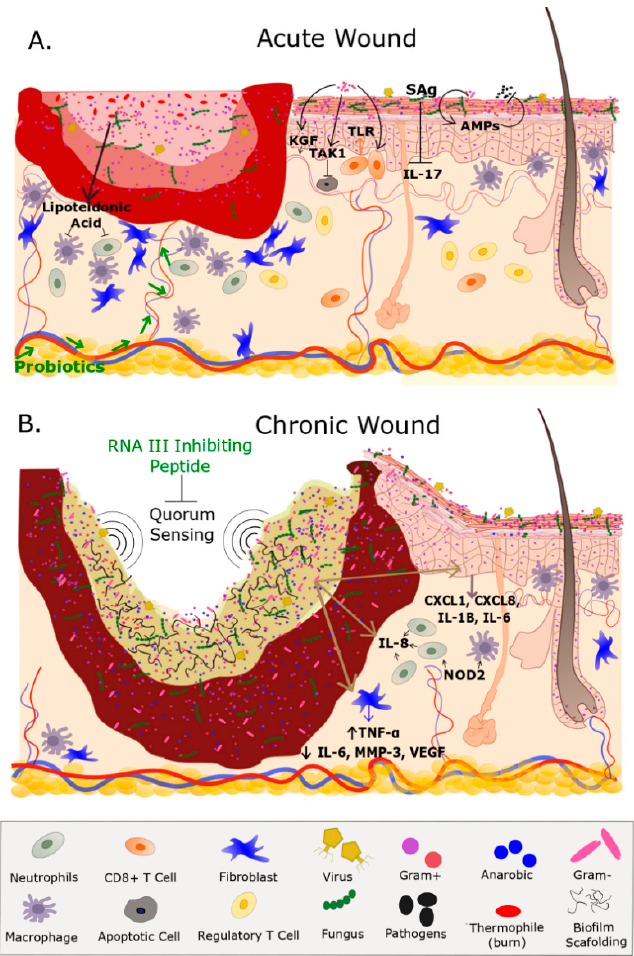
Figure 1. Microbiome, Wound Healing, and Wound Healing Impairment. ( A ) Acute wounds such as burns and open fractures contain a microbiome that may or not contain a vastly different population than what is on undamaged adjacent skin. The microbes present on an acute wound don’t necessarily impede the inflammatory response therefore allowing for the highly coordinated events that promote wound healing. Several fibroblast, and inflammatory cells such as macrophages, neutrophils, and T Cells are highly involved in the healing process. Production of lipoteichoic acid by S. epidermidis deceases inflammation. Keratinocytes express anti-microbial peptides (AMPs) in response to S. epidermidis , S. aureus , Group A streptococcus which provides protection for pathogenic bacterium.